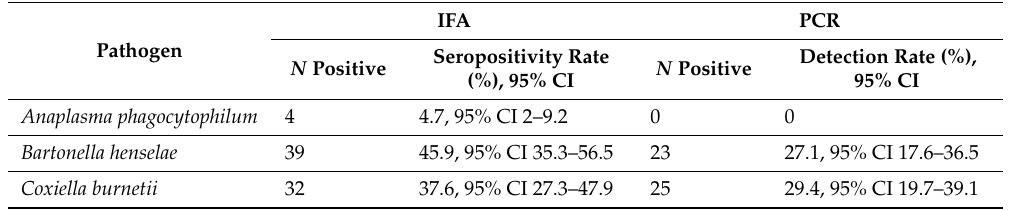
Table 2. Results of the serological (indirect immunofluorescent assay, IFA) and molecular (PCR) tests for protozoa and bacteria of the 85 cats analyzed. CI, confidence